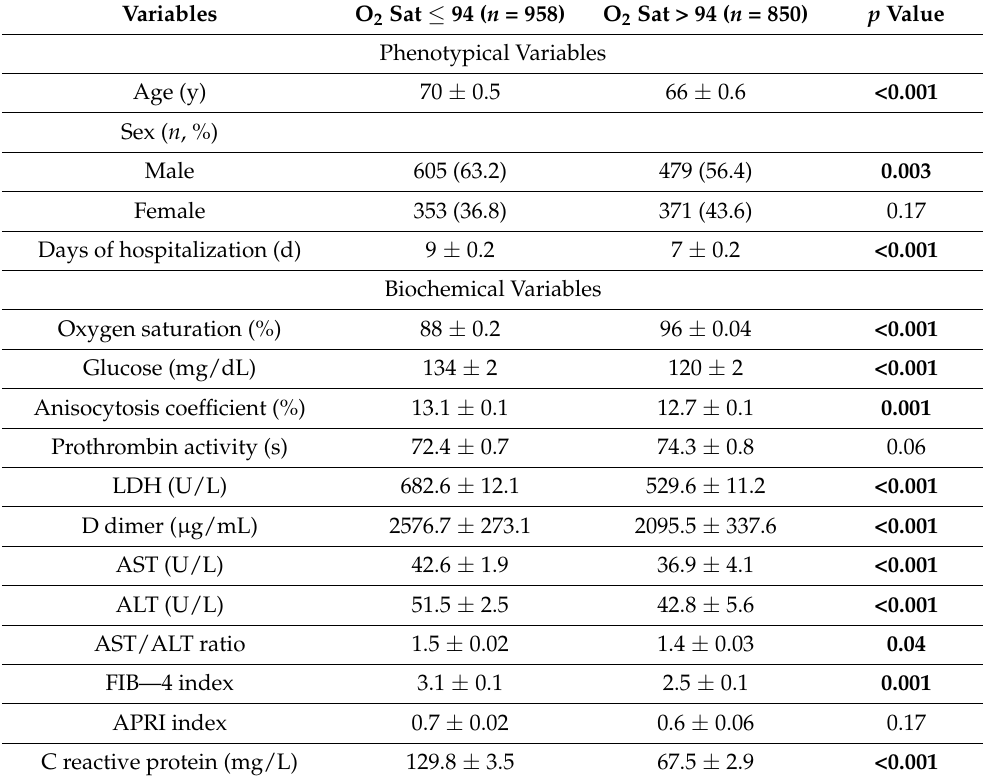
Table 1. Comparison of clinical and phenotypical variables of COVID-19 infected patients according to oxygen